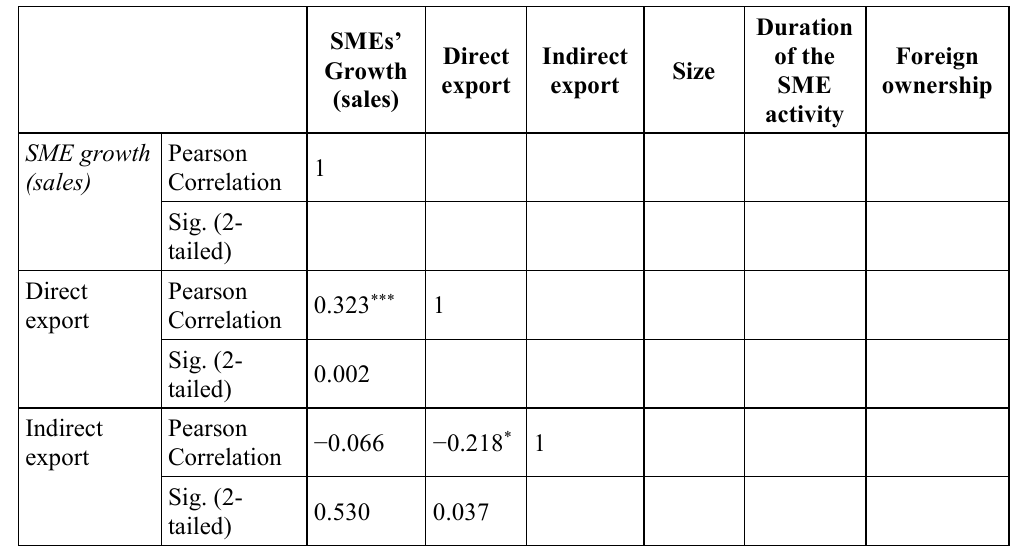
Table 3. Correlation